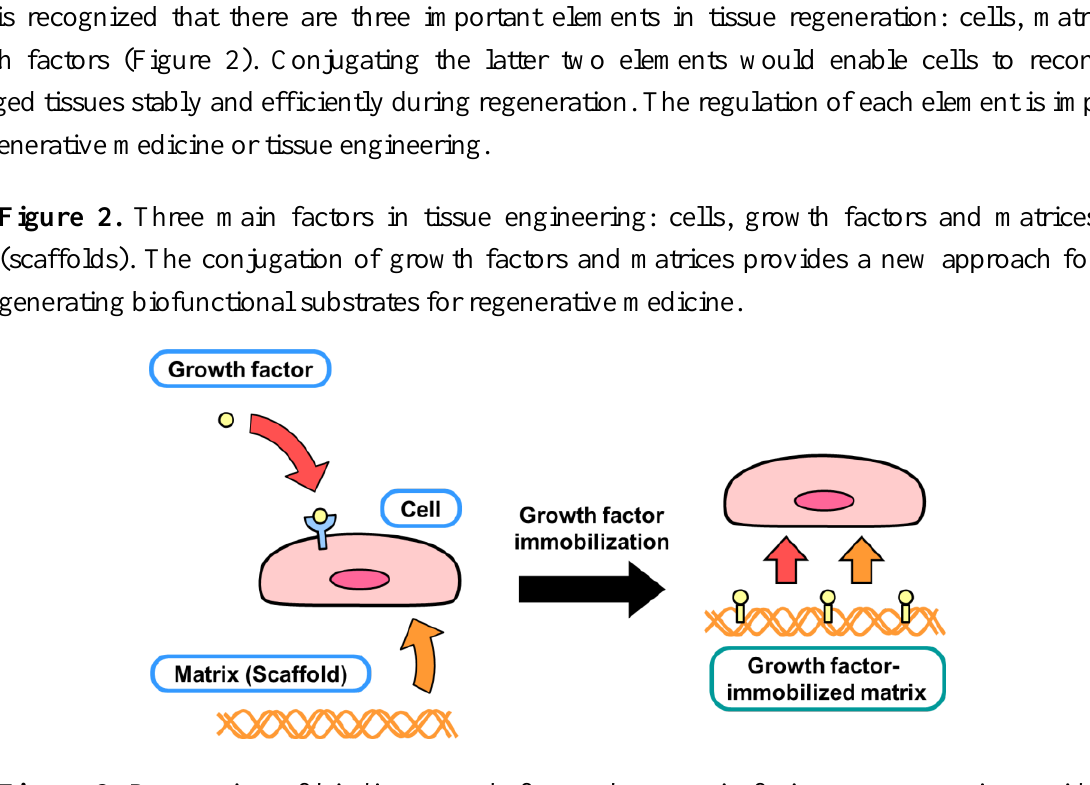
Figure 3. Preparation of binding growth factors by genetic fusion or enzymatic peptide ligation methods. Whereas the genetic fusion method has been used in most studies of binding growth factors, the peptide ligation approach can be used for binding peptides containing noncanonical residues such as phosphorylated amino